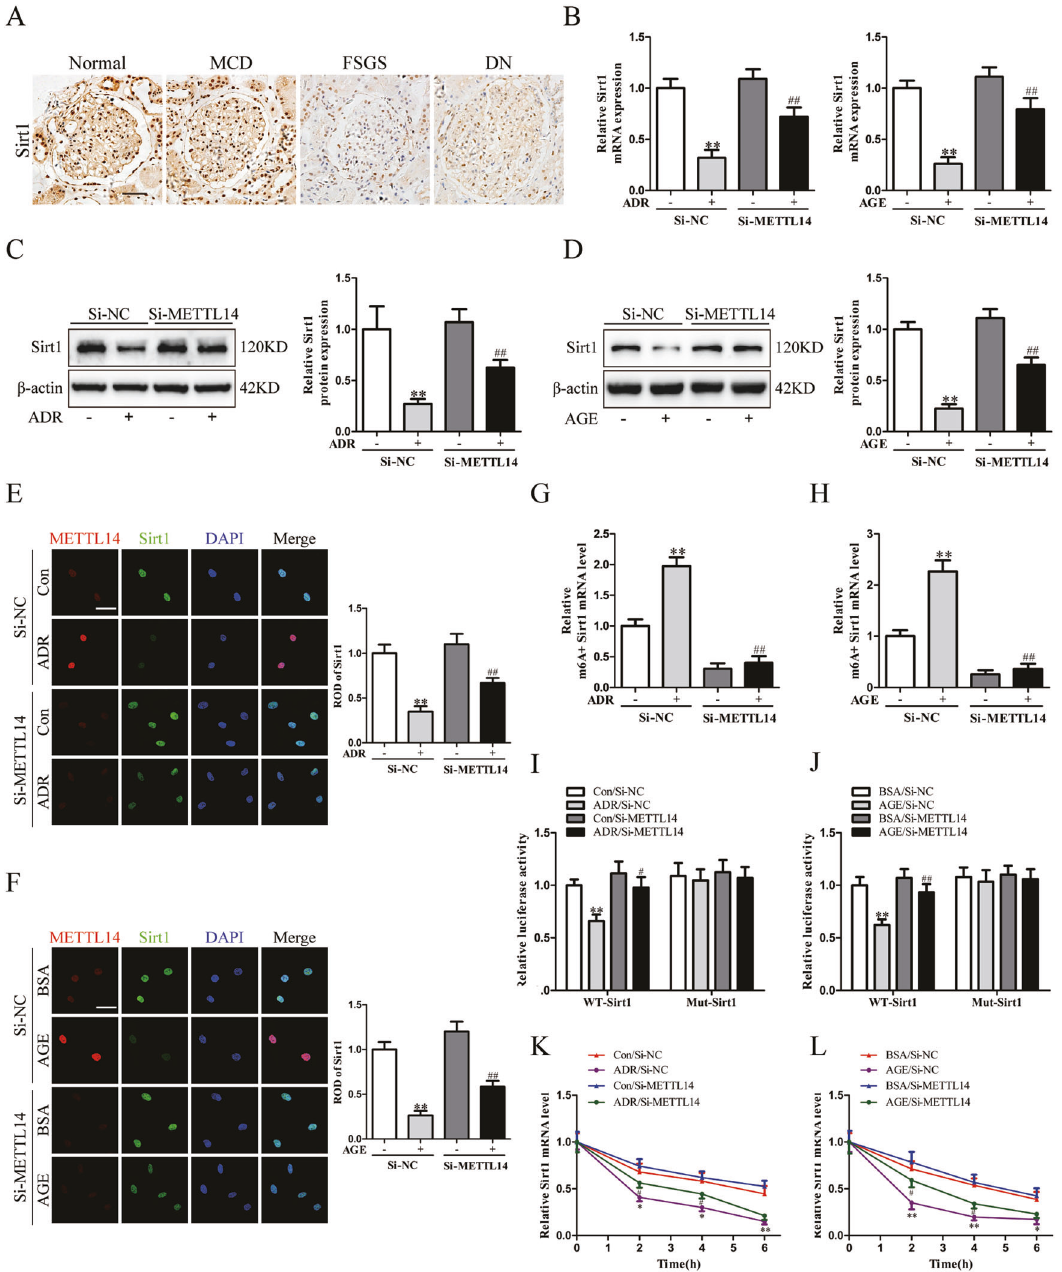
Fig. 7 The protective effect of METTL14 knockdown in injured podocyte relied on promoting Sirt1 mRNA m6A modi fi cation and degradation. A Representative images of immunohistochemical staining for Sirt1 on renal biopsies from normal subjects ( n = 4) and patients with MCD ( n = 6), FSGS ( n = 6) and DN ( n = 8). Scale bars, 20 μ m. B The relative mRNA levels of Sirt1 in podocytes transfected with SiNC or SiMETTL14 under ADR (0.4 μ g/ml) or AGE (50 μ g/ml) condition for 24 h ( n = 6). C Western blot analysis showing the upregulation of Sirt1 expression in ADR-treated podocytes ( n = 6). D Western blot analysis showing METTL14 knockdown weakened AGE-induced inhibition of Sirt1 expression in podocytes ( n = 6). E , F Representative confocal microscopic images and quanti fi cation of immuno fl uorescence co-staining for METTL14 and Sirt1 in podocytes transfected with SiNC or SiMETTL14 under ADR or AGE condition. Scale bar, 40 μ m ( n = 6). G , H MeRIP- qPCR analysis in podocytes with different treatment. The results indicated ADR or AGE intervention promoted m6A antibody binding with Sirt1 mRNA. METTL14 silencing ameliorated the upregulation of methylated Sirt1 mRNA levels induced by ADR or AGE treatment ( n = 5). I , J Luciferase assays were performed in podocytes transfected with wild-type or mutant Sirt1 reporter plasmids under different condition. AGE or ADR administration attenuated the luciferase activity of podocytes transfected with wild-type Sirt1 reporter plasmids. METTL14 knockdown in podocytes relieved the reduction of luciferase activity induced by AGE or ADR treatment. However, ADR or AGE intervention had no effect on the luciferase activity of podocytes transfected with mutant Sirt1 reporter plasmids ( n = 5). K , L Podocytes with different treatment were followed by incubation with actinomycin D for 0, 2, 4, 6 h. The decay curves of Sirt1 mRNA were shown. All values are normalized as fractions of the original mRNA levels ( n = 6). * P < 0.05, ** P < 0.01 vs. Con/BSA + SiNC group, # P < 0.05, ## P < 0.01 vs . ADR/AGE + SiNC group. Data are presented as mean ±